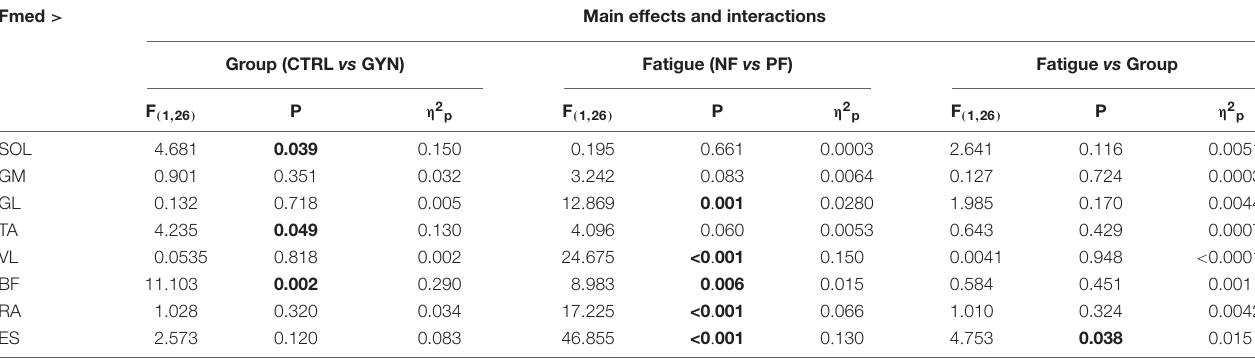
TABLE 4 | Statistical results of the two-way ANOVAs applied to the measurements of the median frequency of the EMG signal (Fmed) before and after the fatiguing protocol. Fmed > Main effects and interactions Group (CTRL vs GYN) Fatigue (NF vs PF) Fatigue vs